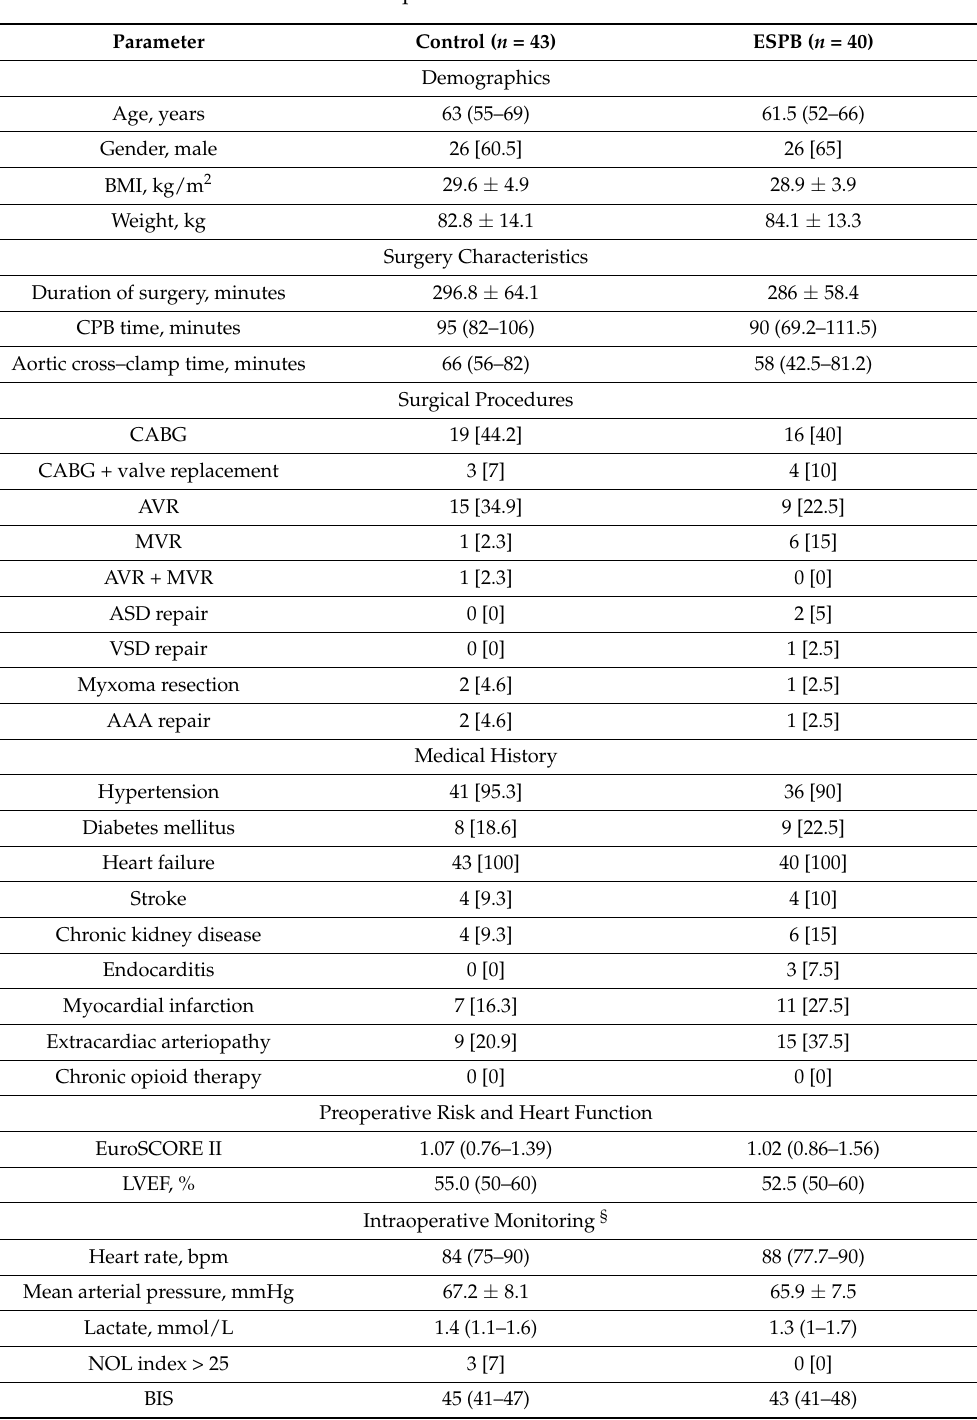
Table 1. Patient Characteristics and Perioperative